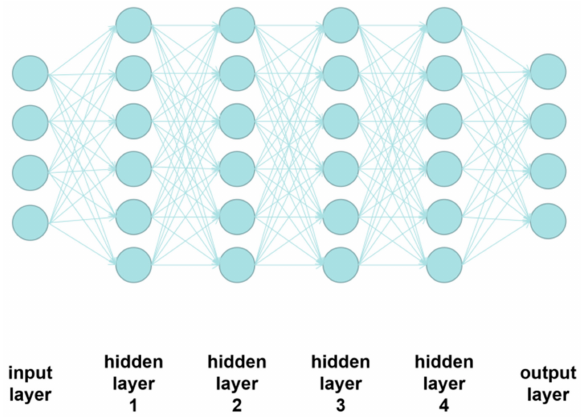
Figure 4. Schematic of the NN